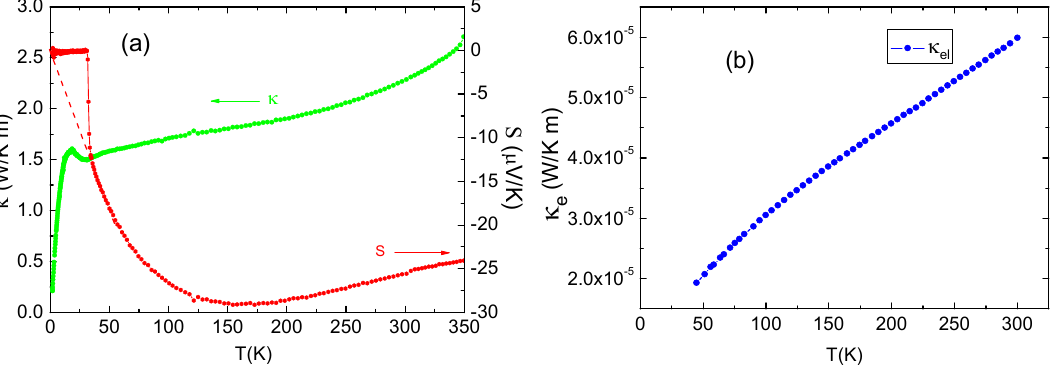
Figure 10. ( a ) Temperature dependence of thermal conductivity and the Seebeck coefficient for Ca 10 (Pt 4 As 8 )((Fe 0.86 Pt 0.14 ) 2 As 2 ) 5 ; ( b ) electronic contribution to thermal conductivity above transition temperature T c evaluated by the Wiedemann–Franz law.